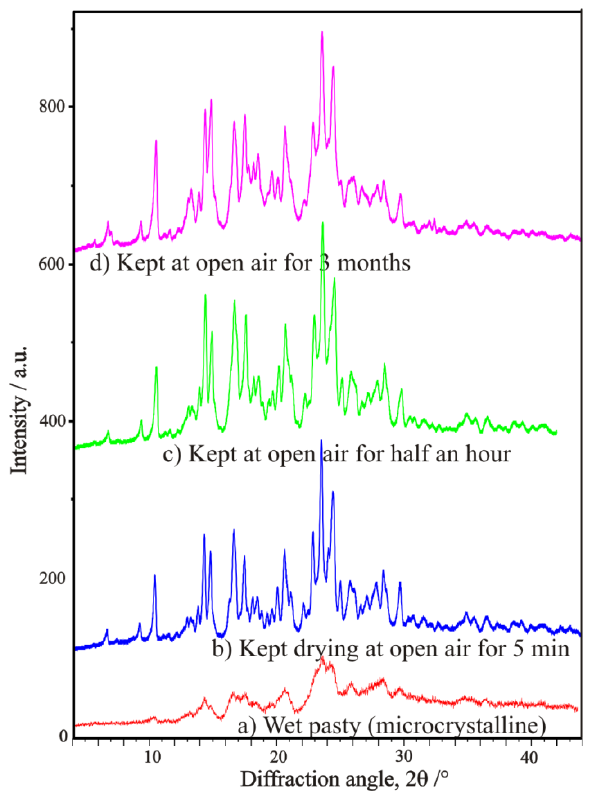
Figure 28. Powder XRD profiles of a precipitated tofizopam- (R , R)- DBTA -CHCl 3 diastereomeric salt solvate sample, showing the open-air drying process starting from its ‘wet’ pasty microcrystalline state during keeping it at open-air for various times, as long as 5 min, half an hour, and 3 months (Figure based on Ref. [15]).